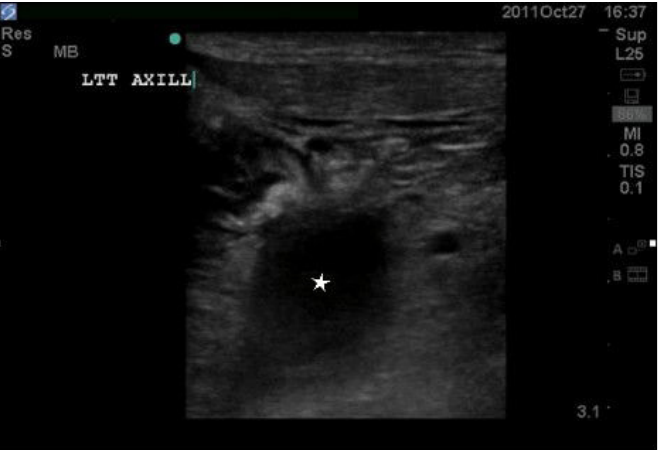
Figure 5. Ultrasound image demonstrating clot in left axillary vein (star).